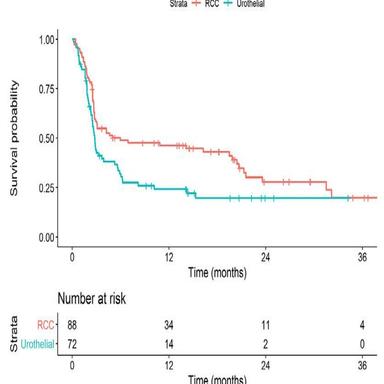
Kaplan-Meier curves of progression free survival stratified by GU malignancy subtype. GU = genitourinary; RCC = renal cell carcinoma.